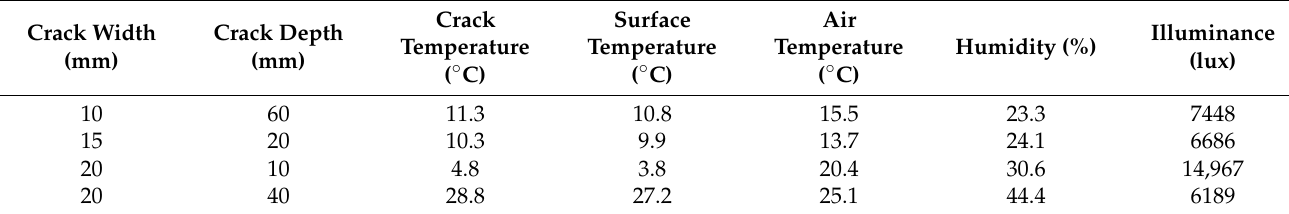
Table 3. Example of raw data.